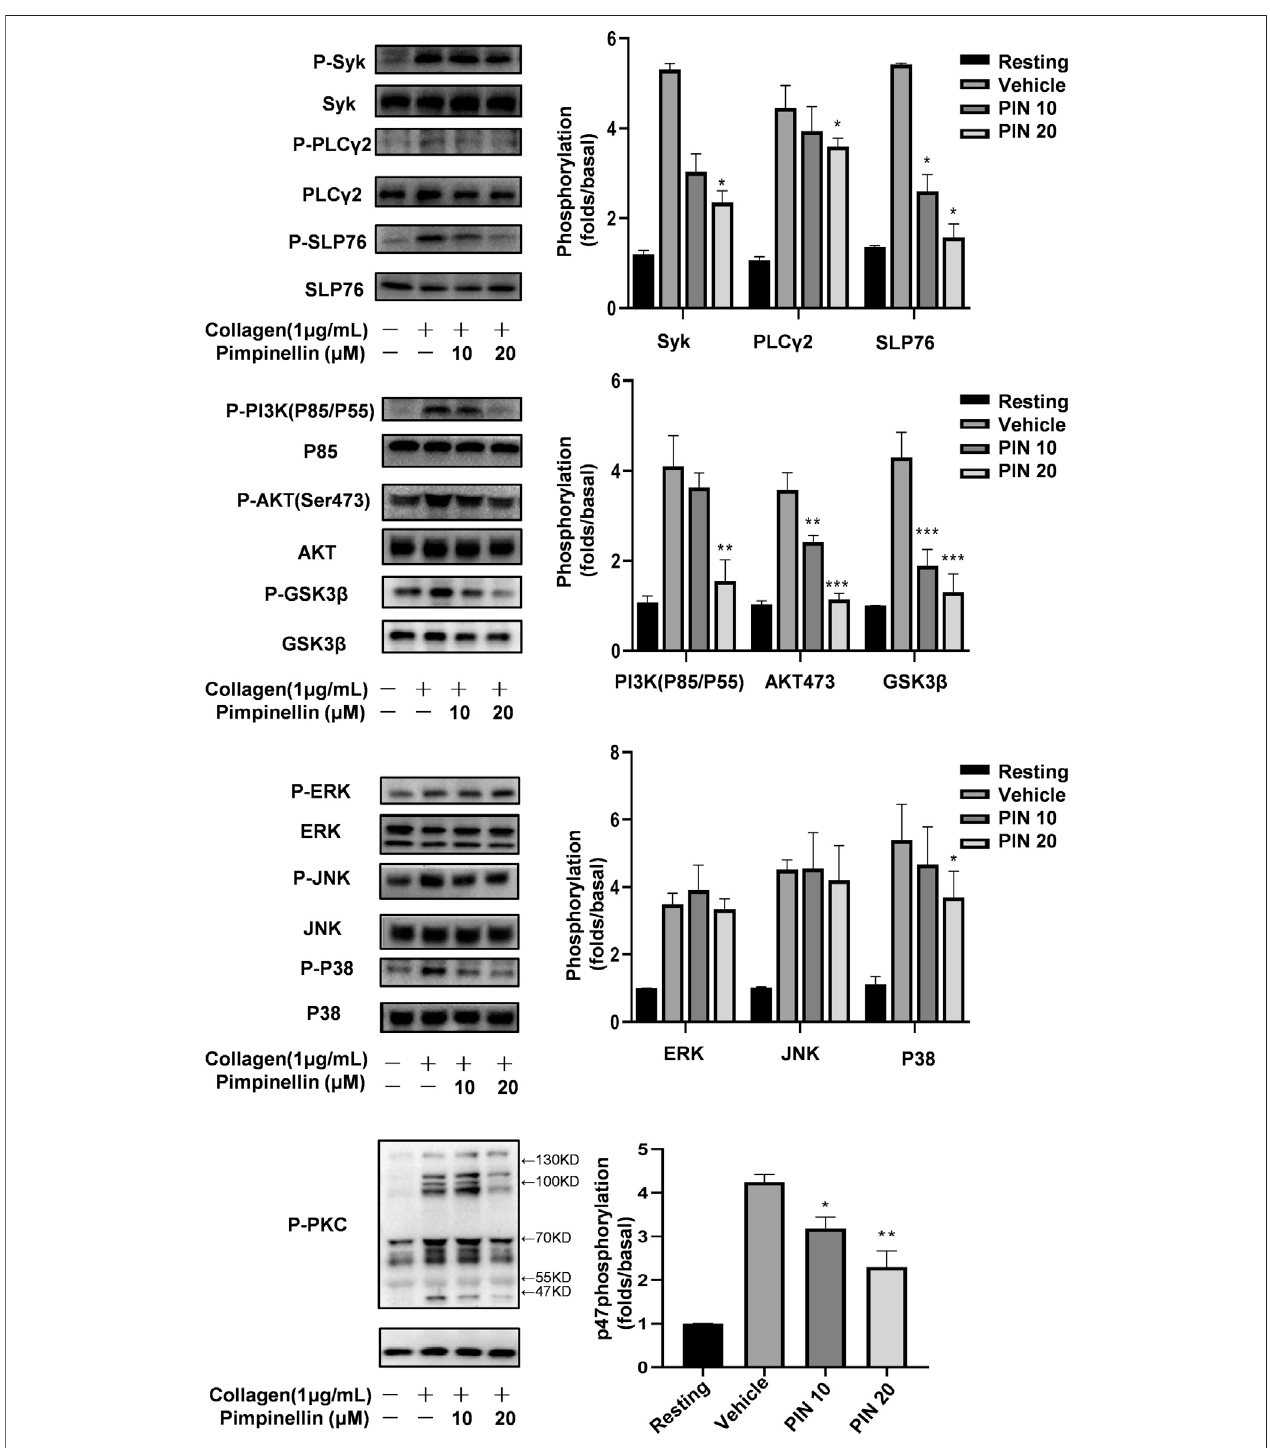
FIGURE5| Effectofpimpinellinoncollagen-inducedsignaltransduction.Washedplateletswerestimulatedwith2 μ g/mlcollagen(3.0 × 10 8 /ml)andthenlysedwith cell lysis buffer. Syk, PLC γ 2, SLP76, JNK, ERK, P-38, p85, Akt, GSK3 β , and PKC phosphorylation levels were detected with relevant antibodies. Band density was analyzedusingtheImageJ software. Dataarepresented asthemean ± SEM( n (cid:2) 3).* p < 0.05and ** p < 0.01comparedtothevehicle group; NS means nosigni fi cance.